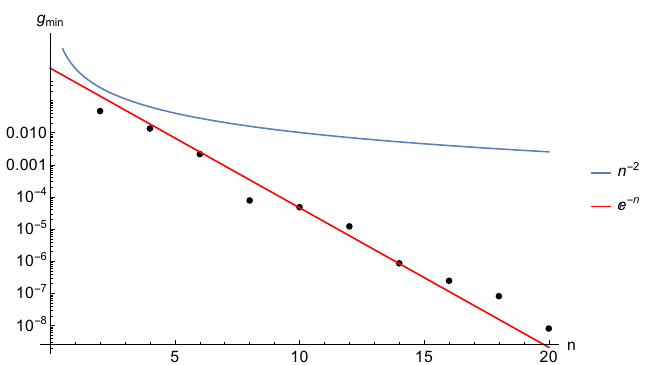
Figure 2. Minimum gap against n in the adiabatic evolution, from the critical ground state of the Ising model to the critical ground state of the Heisenberg XXZ model. The red line represents e − n , making the time of adiabatic evolution scale exponentially. Blue line shows n − 2 for comparison purpose. Log scale on y